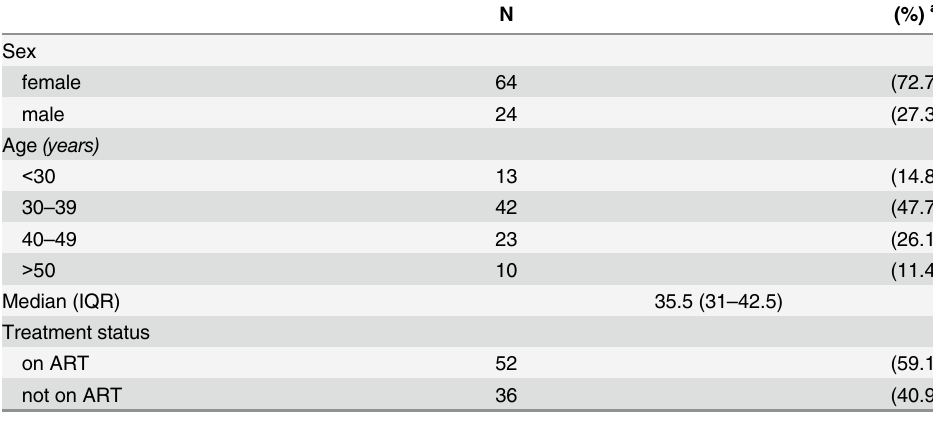
Table 1. Characteristics of study participants at